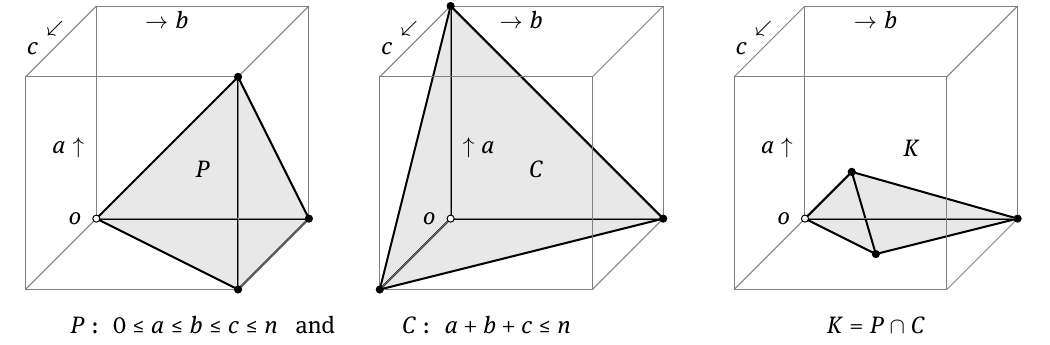
Figure 11: The tetrahedron K as intersection a path tetrahedron P and a cube corner C .